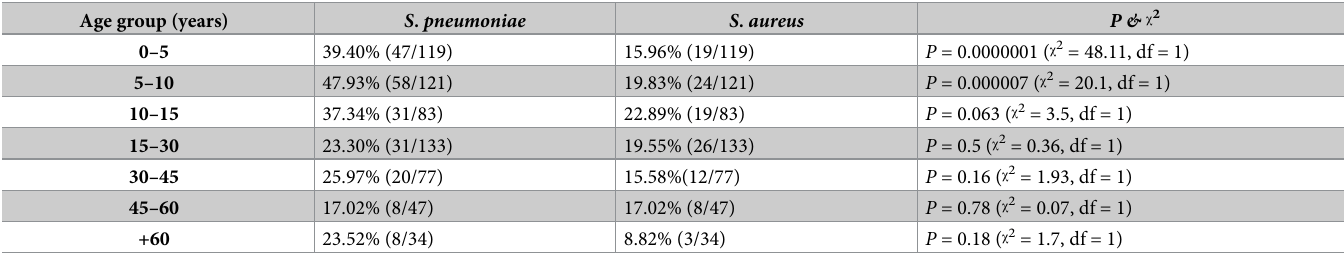
Table 3. Results of prevalence of pathogenic bacteria in Dielmo and Ndiop by Age-group. Age group